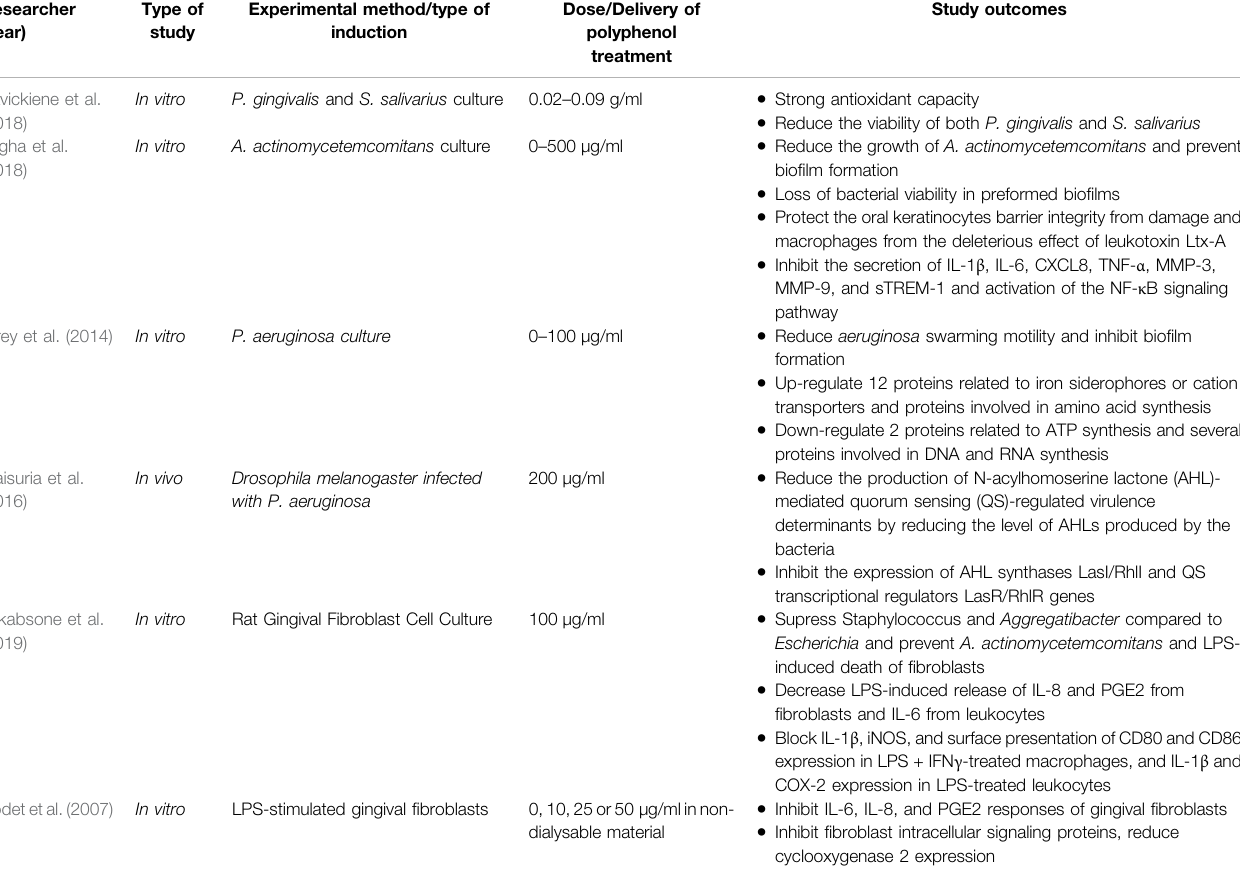
TABLE 4 | The effects of proanthocyanidins in periodontal in fl ammation, in vivo and in vitro